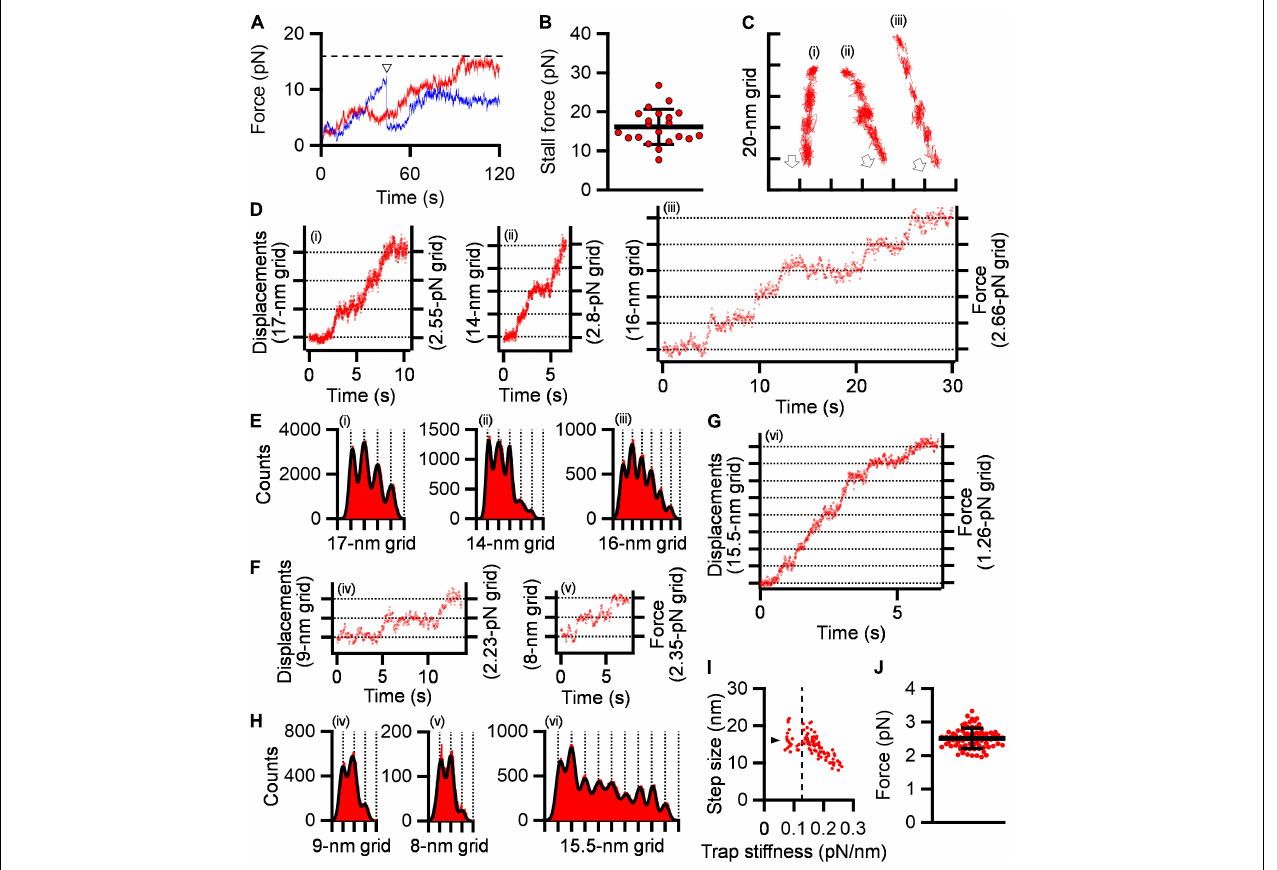
FIGURE 4 | Stepwise movements under SL. (A) Representative force traces with time under 0.2–0.3 mM SL are shown for stalled (red) and detached (blue) cells. The broken line indicates the stall force. The time point of detachment was marked by a triangle. (B) Scatter dot plot of stall force shown with averages (thick line) and standard deviations (thin lines) ( n = 21). (C) Three cell trajectories with stepwise movements are shown in a field. Open arrows indicate the gliding direction. (D) Displacement and force of cells whose trajectories are shown in panel (C) . (E) Histograms of pairwise distance function (PDF) analysis of panel (D) were fitted by the sum of Gaussian curves. (F) Displacement and force under high trap stiffness. (G) Displacement and force under low trap stiffness. (H) Histograms of PDF analysis of panels (F,G) . (I) Distribution of step size under various trap stiffnesses. Step sizes were plotted as a function of trap stiffness ( n = 97). The position at 0.12 pN/nm of trap stiffness was marked by a dotted line. The average of step size under 0.07–0.12 pN/nm of trap stiffness was marked by a triangle. (J) Scatter dot plot of force increments under 0.13–0.26 pN/nm of trap stiffness shown with averages (thick line) and standard deviations (thin lines) ( n =